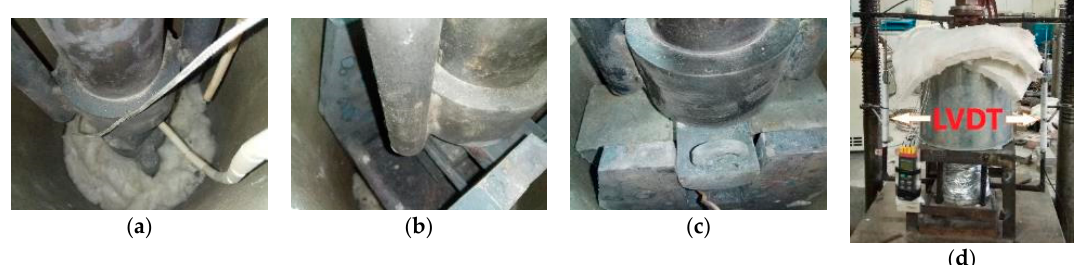
Figure 3. Experimental setup for hot-strength tests: ( a ) compressive strength test, ( b ) split-tensile strength test, ( c ) flexural strength test, and ( d ) elastic modulus test.